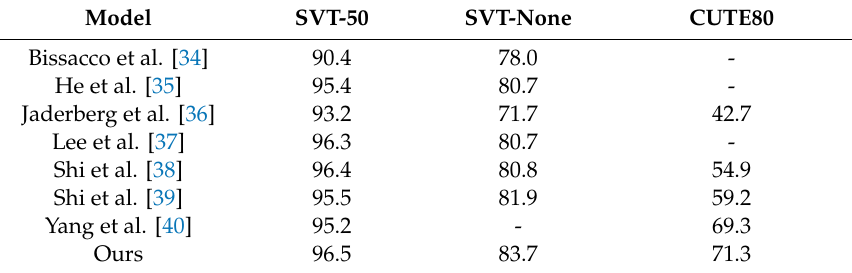
Table 8. Recognition accuracies (%) compared with other text recognition